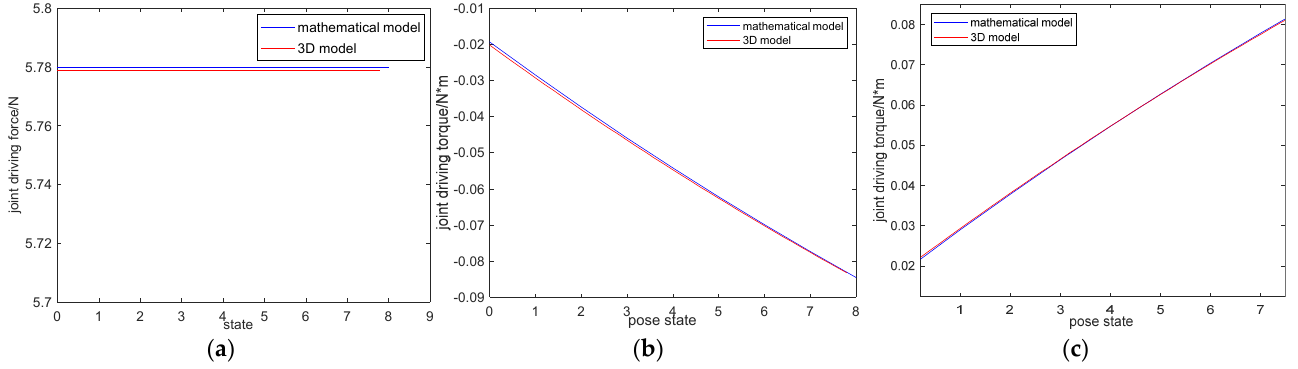
Figure 11. Comparison results of simulation 1. ( a ) Upper kinematic chain; ( b ) Bottom kinematic chain 1; ( c ) Bottom kinematic chain 2.